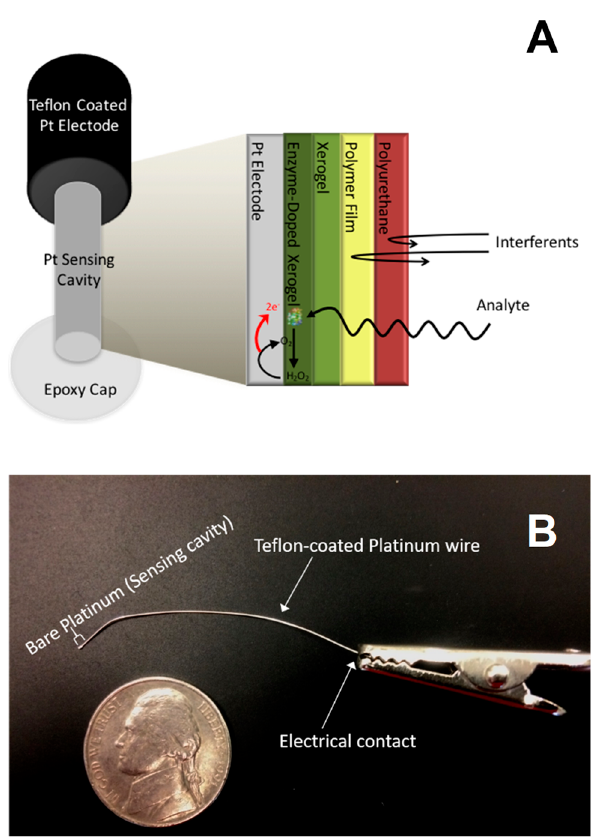
Figure 1. ( A ) Generic LbL scheme at the wire electrode interface that can feature some combination of materials such as enzyme-doped and/or undoped xerogel, electrochemically deposited semi-permeable polymers, and polyurethane layers; ( B ) photograph of 127 µ m diameter platinum wire with exposed tip for LbL